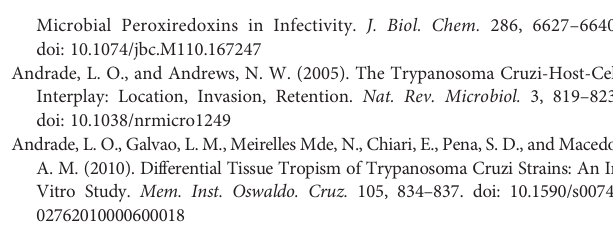
The orange color show those studies where an increase in transcriptomic (light color) and/or functional (dark color) activation of the PI3K/AKT pathway was reported. (PM, Propagation Model; MOI, Multiplicity of Infection; IT, interaction time; AT, analyzed time; ND, No Data available; LLCMK2, Kidney cells from Macaca mulatta; Vero, Kidney cells from Cercopithecus aethiops; L 6 E 9 , Myoblast from rat